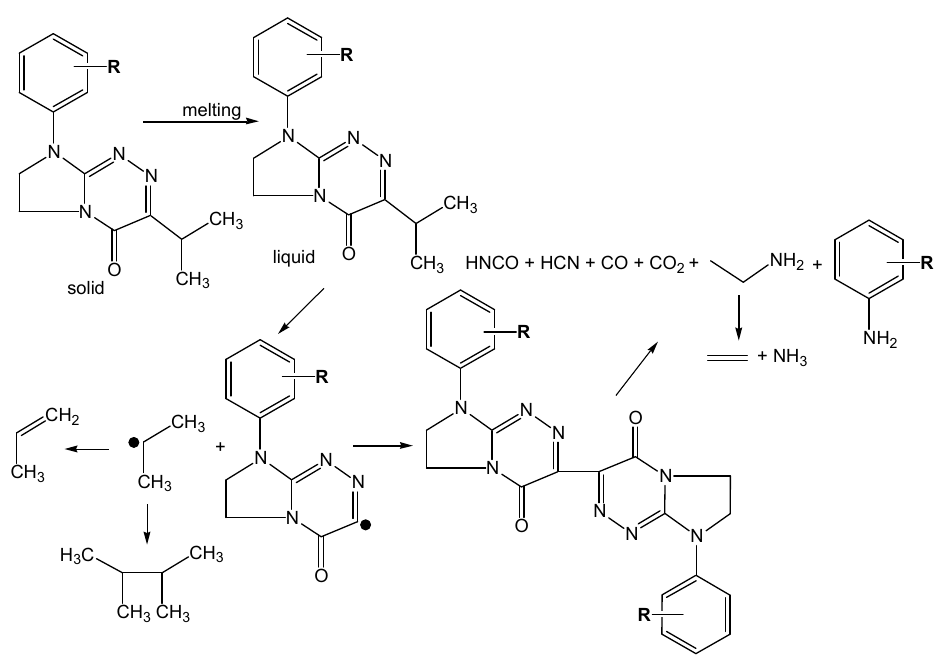
Scheme 1. The pyrolysis products of the tested compounds formed in inert conditions.